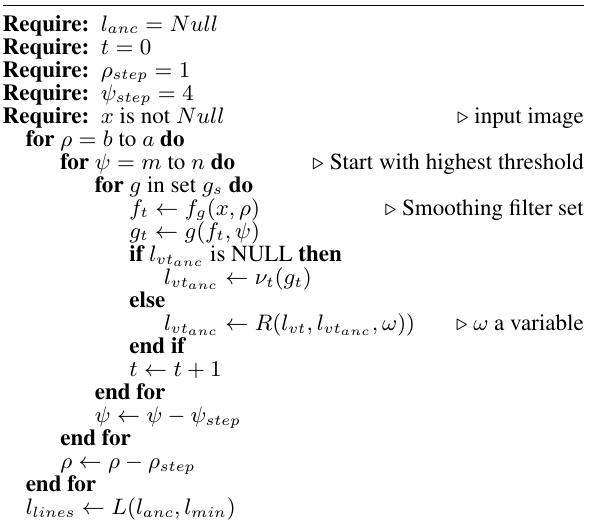
Algorithm 1 Accumulator Framework Algorithm